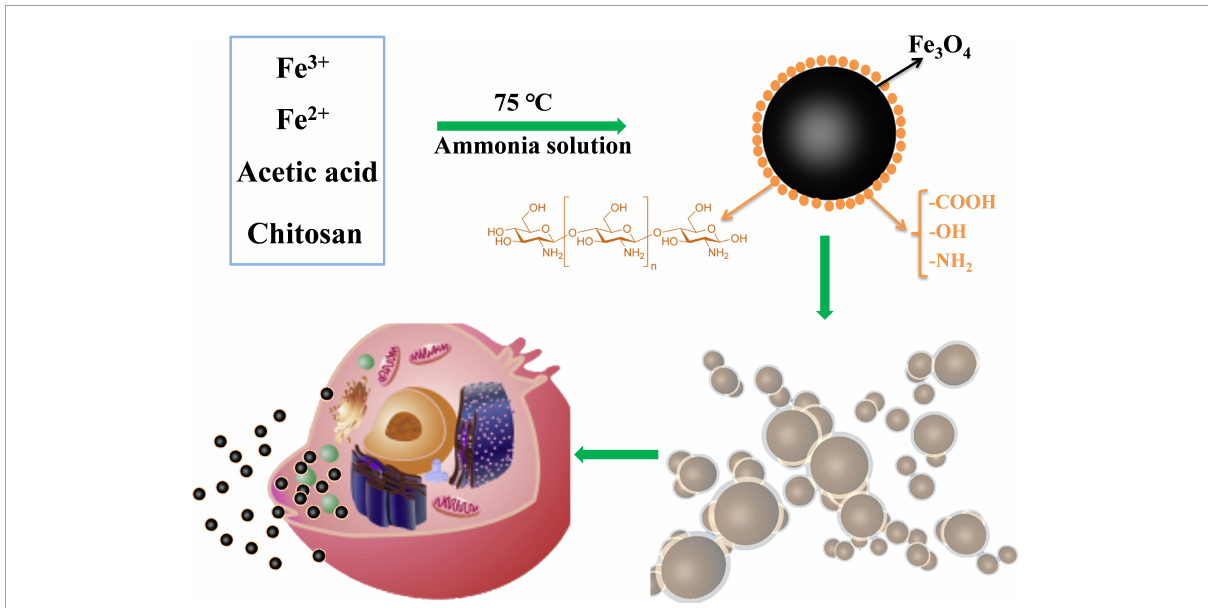
FIGURE9 Schematic diagram showing the preparation of CS-Fe 3 O 4 . The surface functional groups of chitosan-wrapped Fe 3 O 4 nanoparticles improve their cytocompatibility.